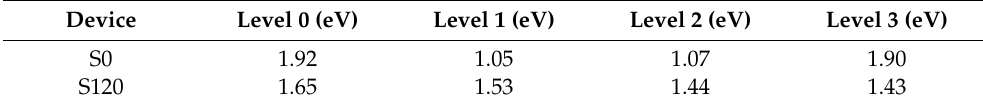
Table 2. Activation energies of storage states for devices S0 and S120.